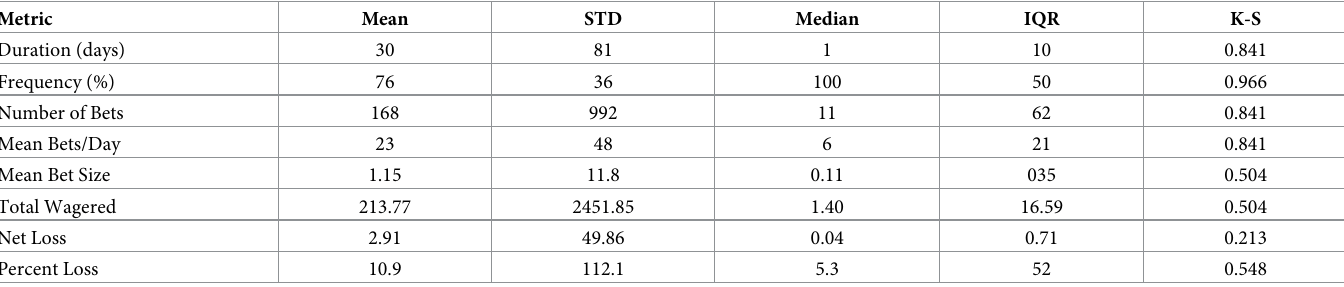
Table 4. Gambling behaviour of 10,357 decentralised gambling application players including a one sample Kolmogorov-Smirnov (K-S) test for normality.